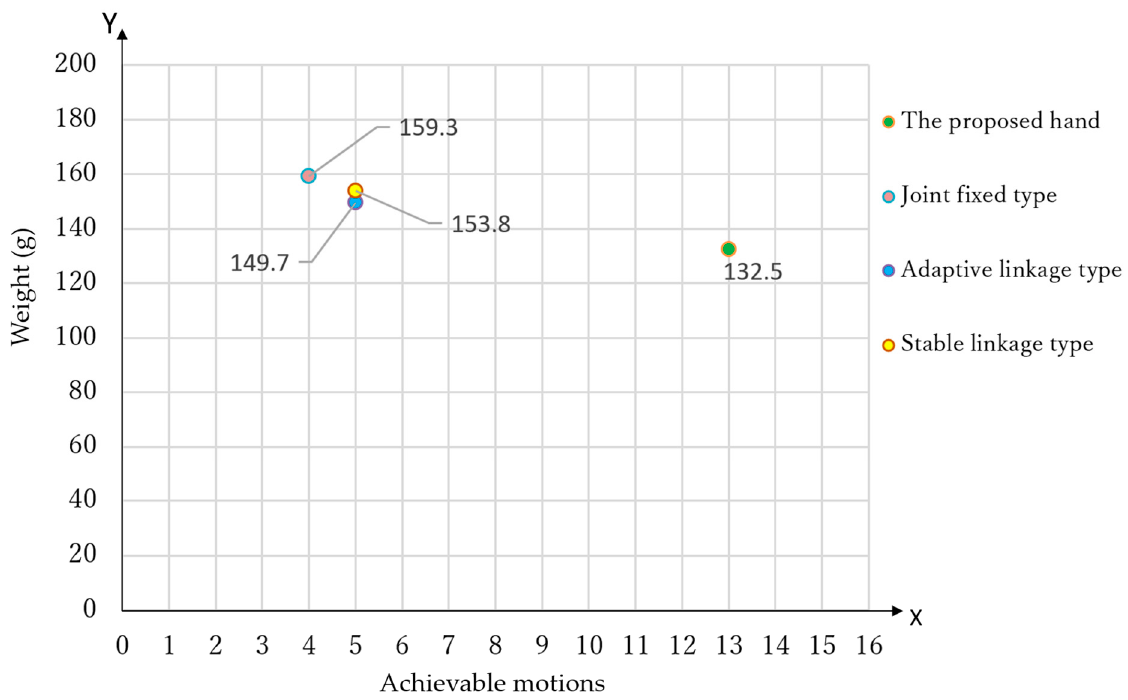
Figure 23. Comparison between the achievable types of motion and entire weight: x-coordinates express the number of achievable types of motion based on the Cutkosky taxonomy; y- coordinates express the entire weight of prosthetic hand.